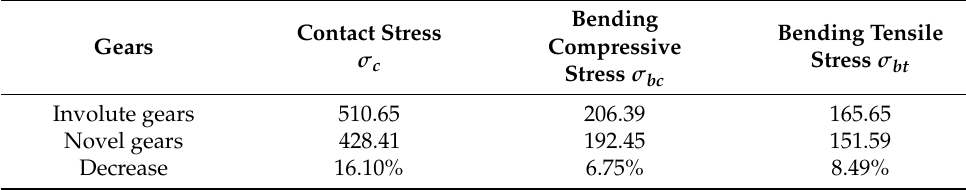
Figure 13. Comparison of bearing capacity between novel gears and involute gears. ( a ) Contact stress; ( b ) Bending compressive stress; ( c ) Bending tensile stress. Table 2. Comparison of maximum stress between novel gears and involute gears